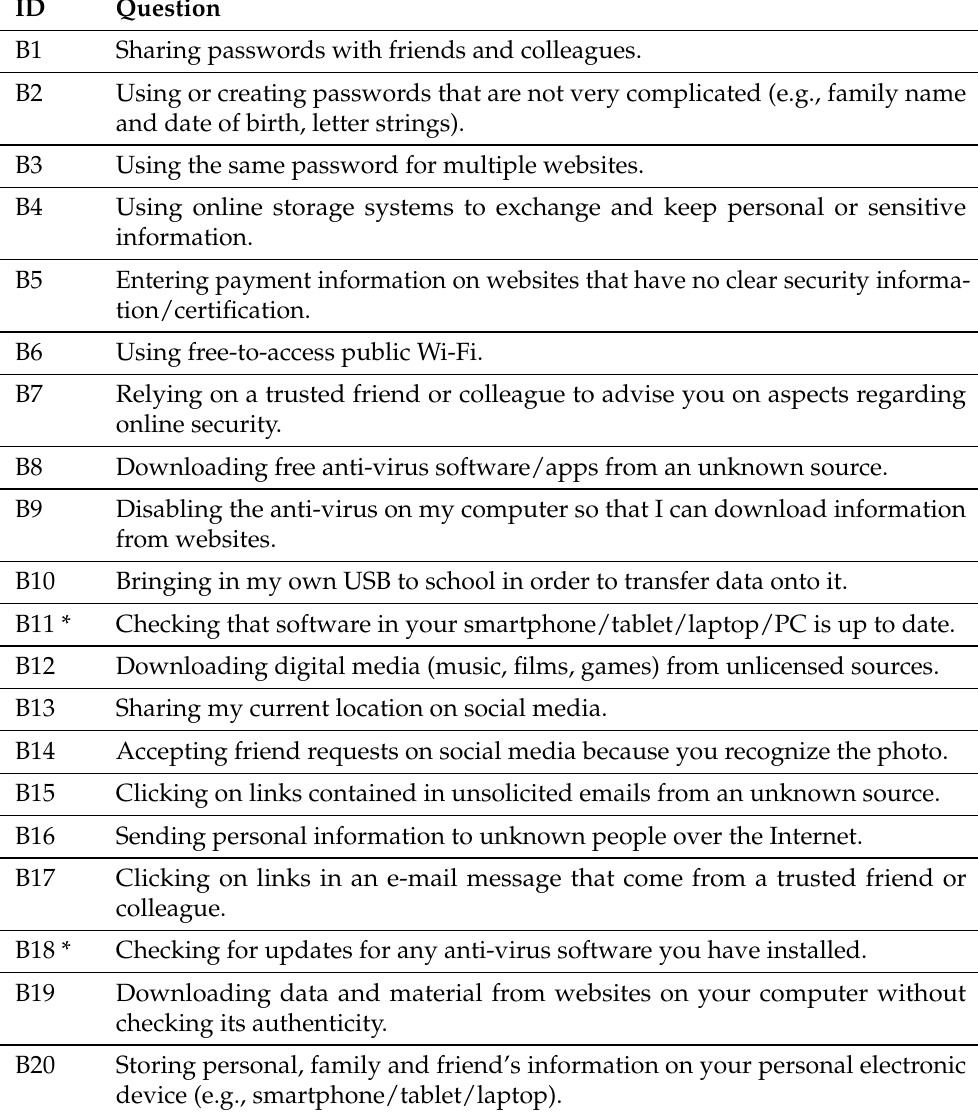
Table 2. Cybersecurity Behaviors in Schools